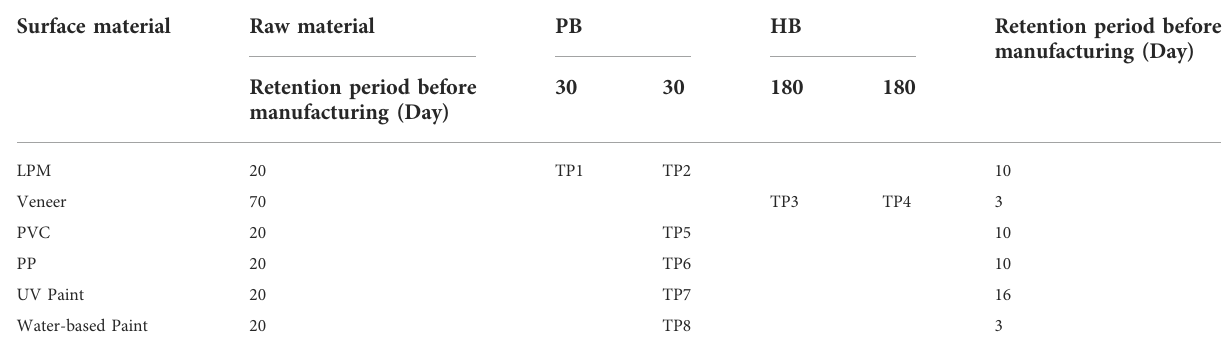
TABLE 4 Test piece composition and experiment start date.